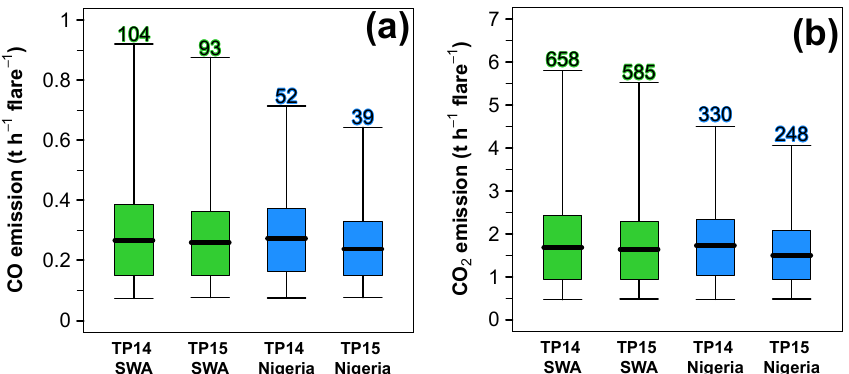
Figure 9. Single flaring emissions of (a) CO and (b) CO 2 ( E clim , th − 1 flare − 1 ) for SWA (green) and Nigeria (blue) for TP14 and TP15. The values above the box plots indicate the emissions per hour, integrated over SWA (green) and Nigeria (blue). The whiskers span the data range from the 0.025 quantile to the 0.975 quantile (95% of the data). Data outside of this range is not